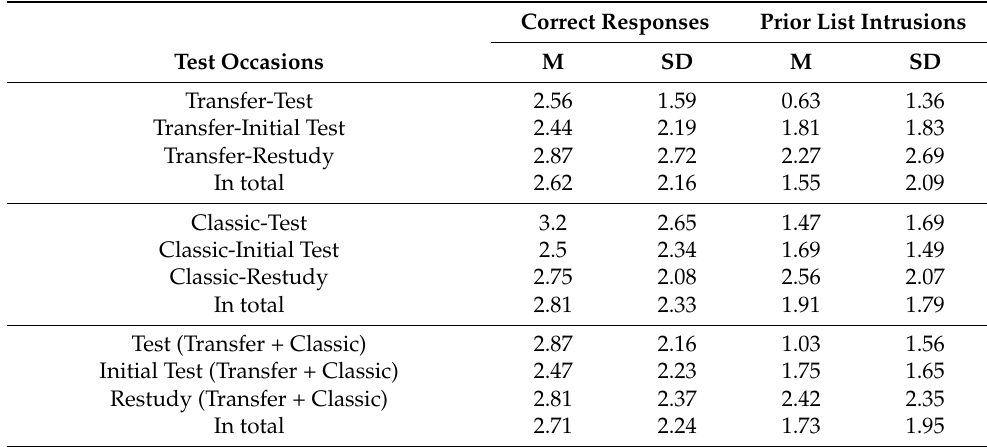
Table 1. Means and standard deviations over the number of correct responses and the number of prior list intrusions in the fourth block’s interim